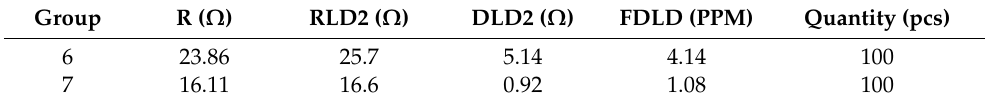
Table 4. Electrical performance parameters of the 6th and 7th groups of blanks at room temperature.